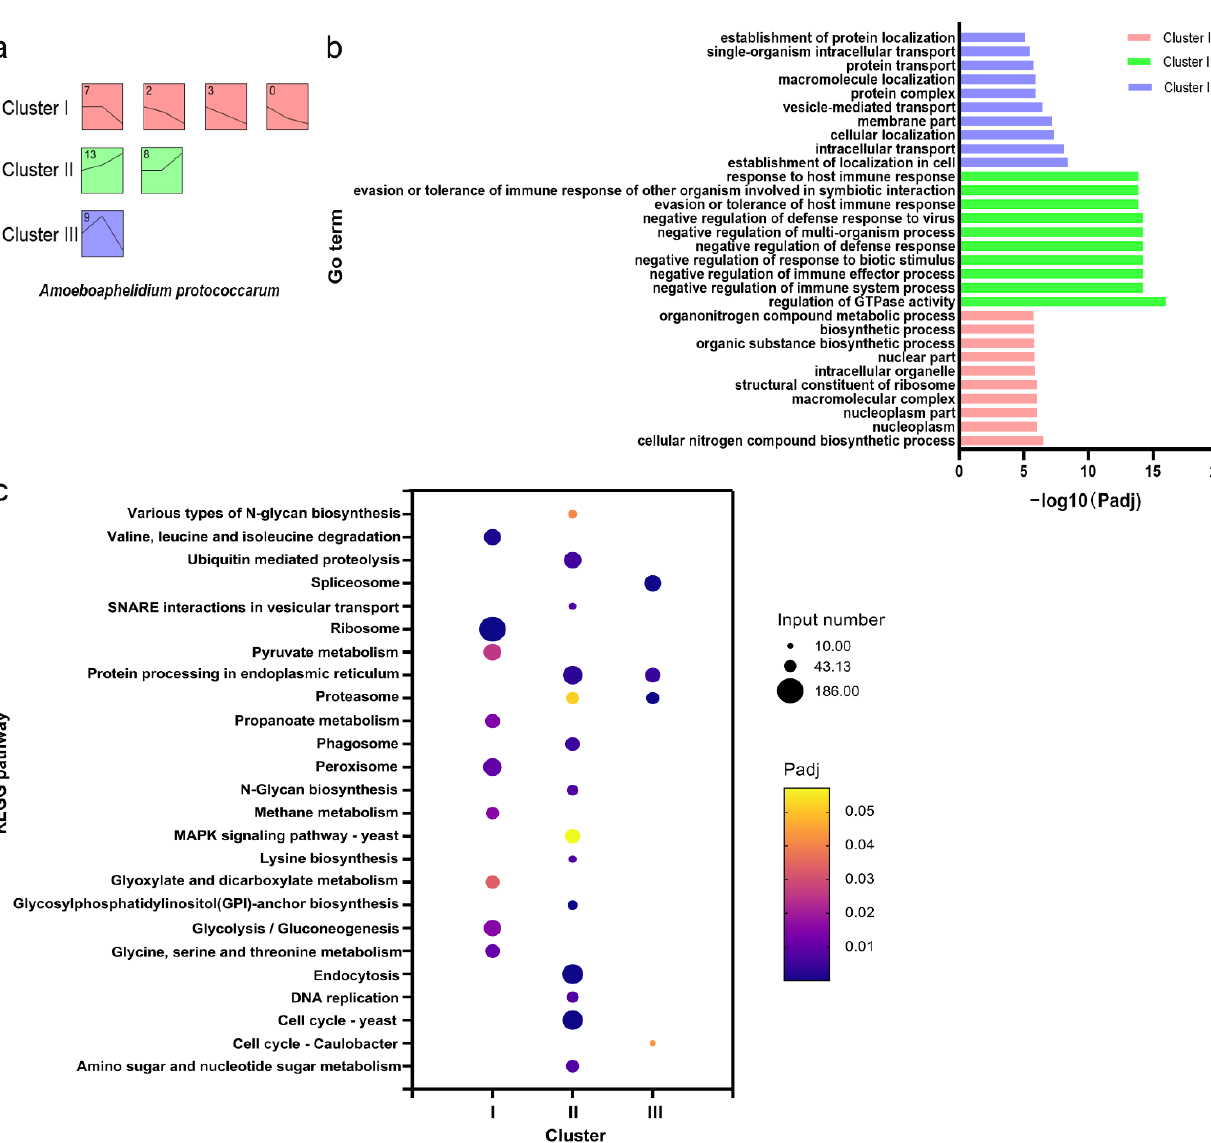
Figure 5. STEM trend and functional enrichment analysis of endoparasite A. protococcarum during infection. ( a ) Three clusters by STEM analysis; ( b ) GO terms enrichment analysis; ( c ) KEGG pathway enrichment analysis.